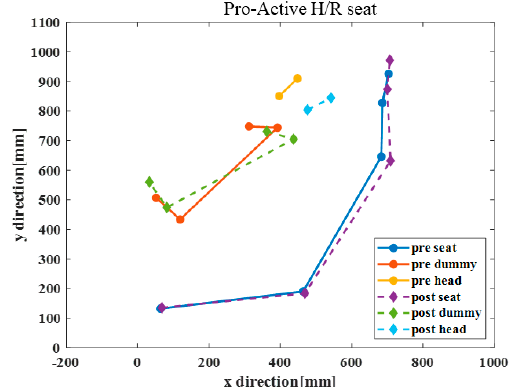
Figure 9. Posture analysis before and after the test on proactive headrest.